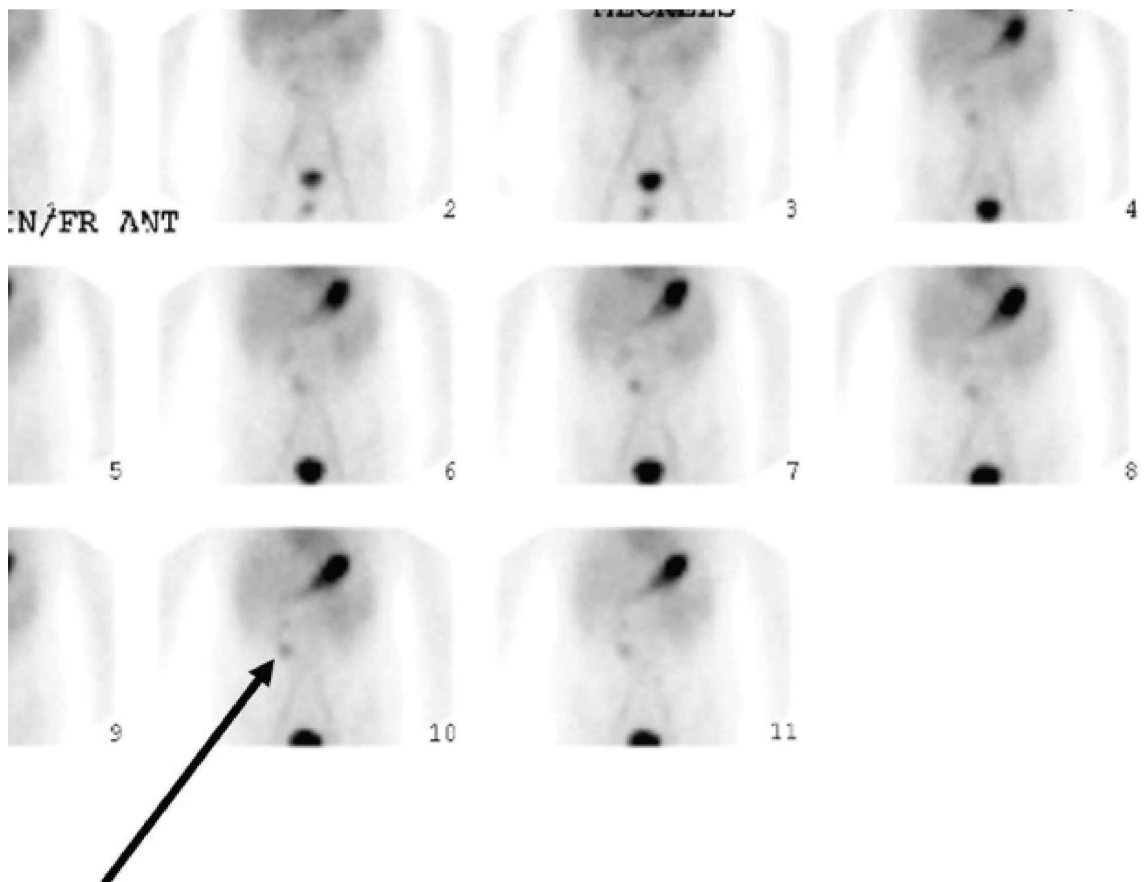
Figure 3: A technetium 99 m pertechnetate scan showed increased focal uptake in the right lower quadrant consistent with Meckel’s diverticulum with ectopic stomach mucosa (black